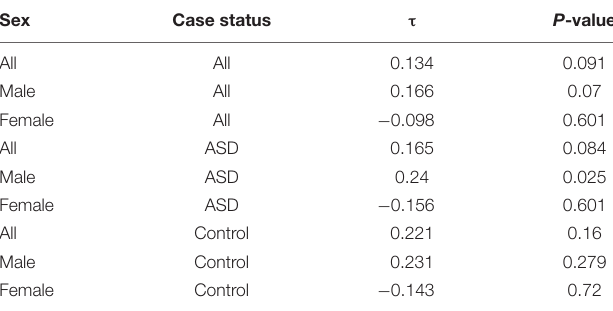
TABLE 6 | Kendall’s Tau rank correlation between serum Se levels and BMI, overall and stratified by sex and case-status.